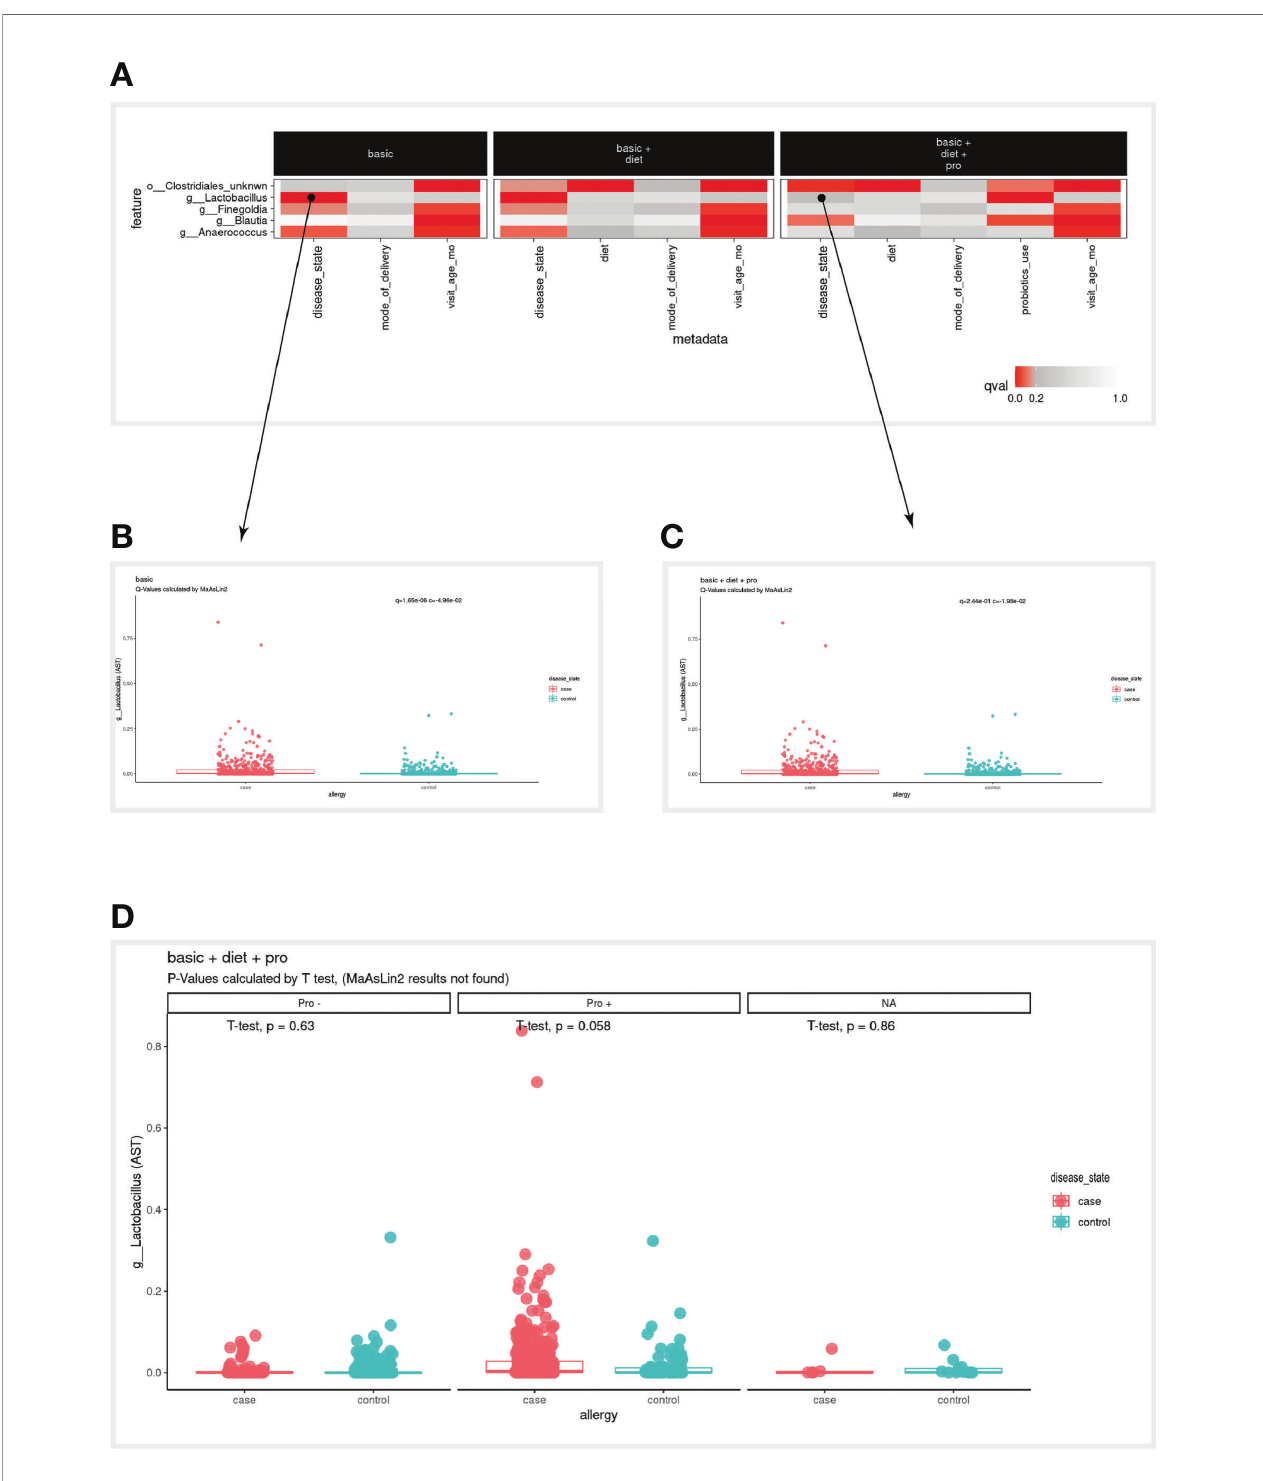
FIGURE 3 | Case study results. (A) A subset of the full heatmap, showing the three tested models with only fi ve selected microbial features (rows). (B, C) Clicking on the heatmap entries marked with a circle, generates these box plots, displaying the linear association of g:Lactobacillus with the disease variable, in the ‘ basic ’ model (B) and from ‘ basic + diet + pro ’ model (C) . In the box plots, each dot represents a sample, where the y-axis is the relative abundance of the microbial feature (AST, see Methods), and the x-axis is the values of the disease variable. (D) Box plot as in (C) strati fi ed by values of the probiotics_use variable (Pro-, Pro+, NA). NA, Not